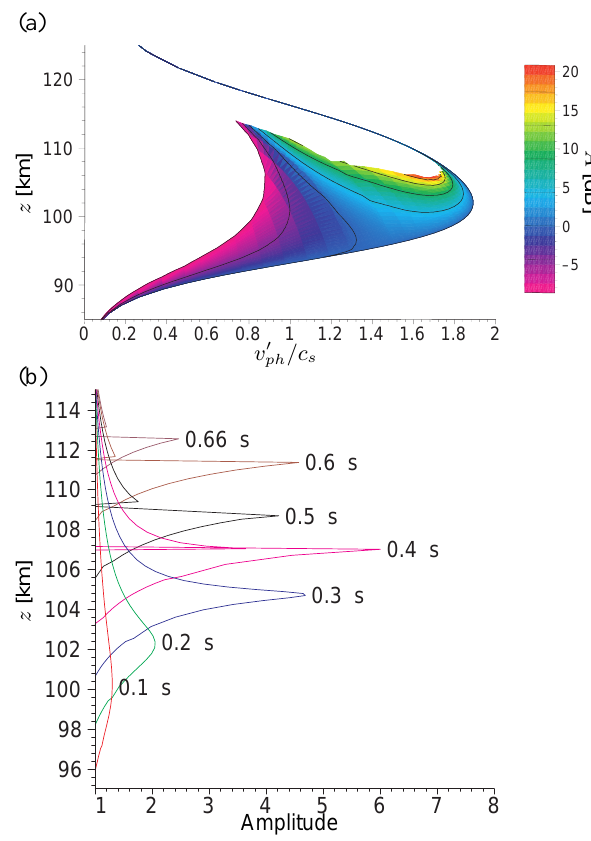
Fig. 11. Same as in Fig. 5 but for a 35 mV/m field. Panel (a) : same as in Fig. 6b. Panel (b) : profile of the amplitude as a function of altitude at various time